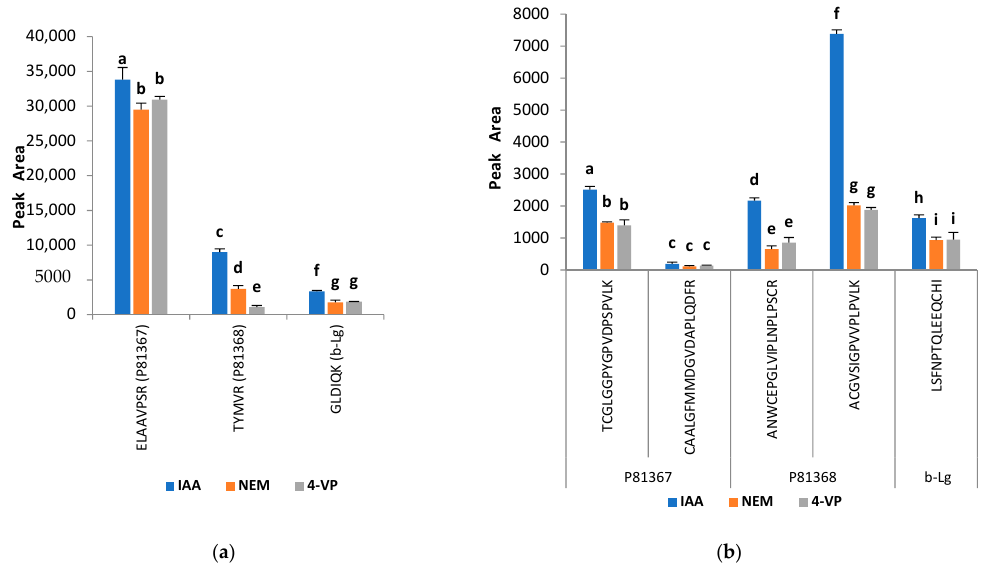
Figure 2 Effect of different alkylating agents on ( a ) quantifier peptides and ( b ) cystine-containing peptides of ATIs P81367, P81368 and β -lactoglobulin ( β -Lg). Tris (2 carboxyethyl) phosphine (TCEP) was used as a reducing agent. Alkylating agents: IAA—iodoacetamide; NEM— N -ethylmaleimide and 4-VP—4-vinylpyridine. Data are expressed as means ± standard deviation, n = 3. Comparisons were performed per family and different letters indicate significantly different values ( p < 0.05).